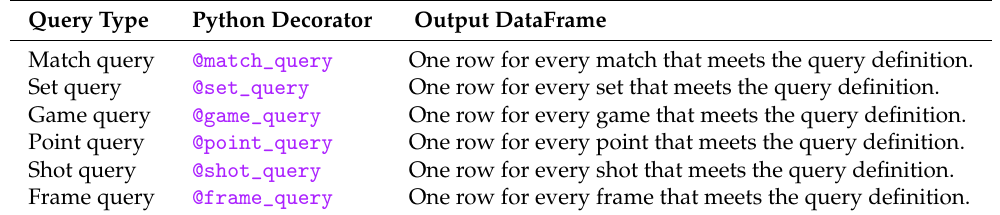
Table 5. Query types supported by our query